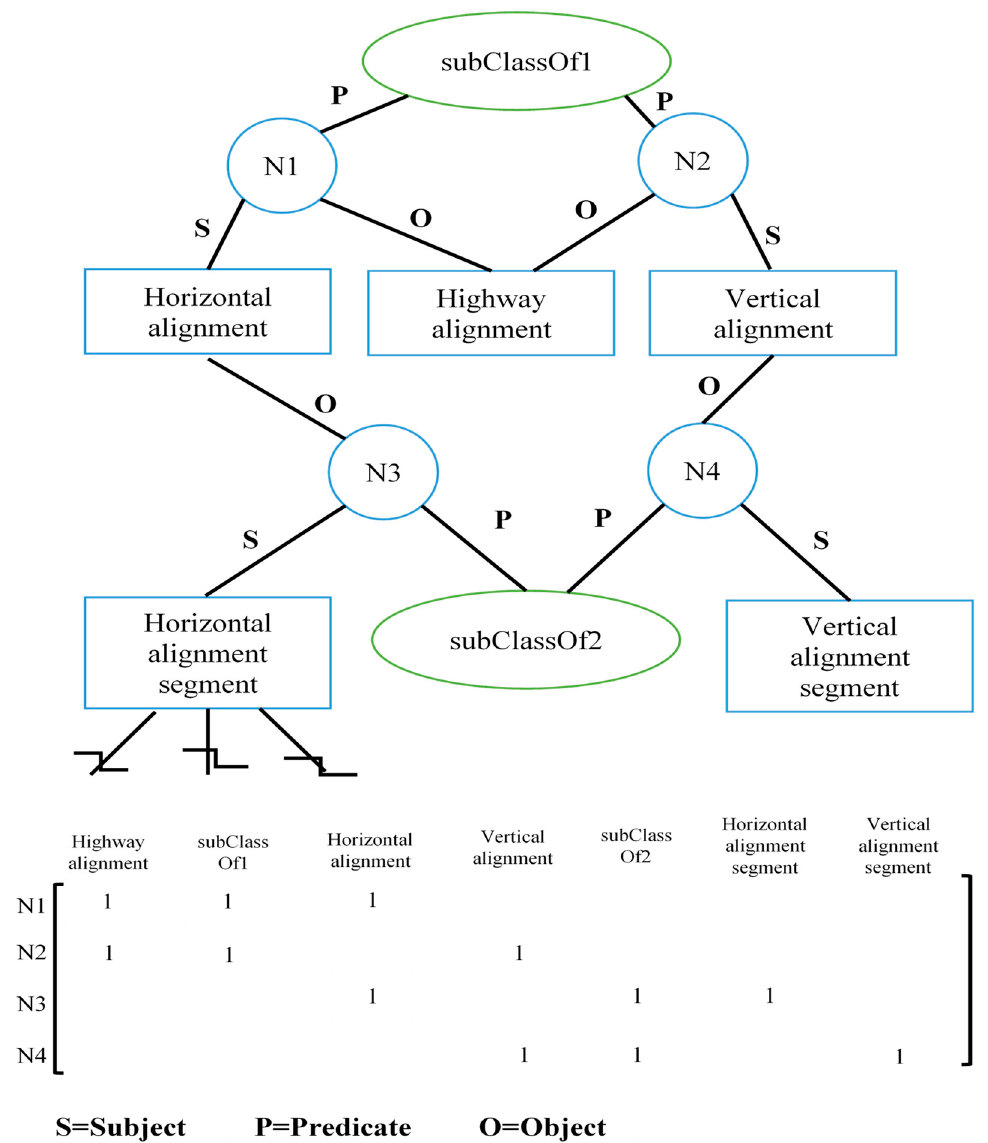
Figure 4. RDF bipartite graph and matrix representation of the BIM ontology example.